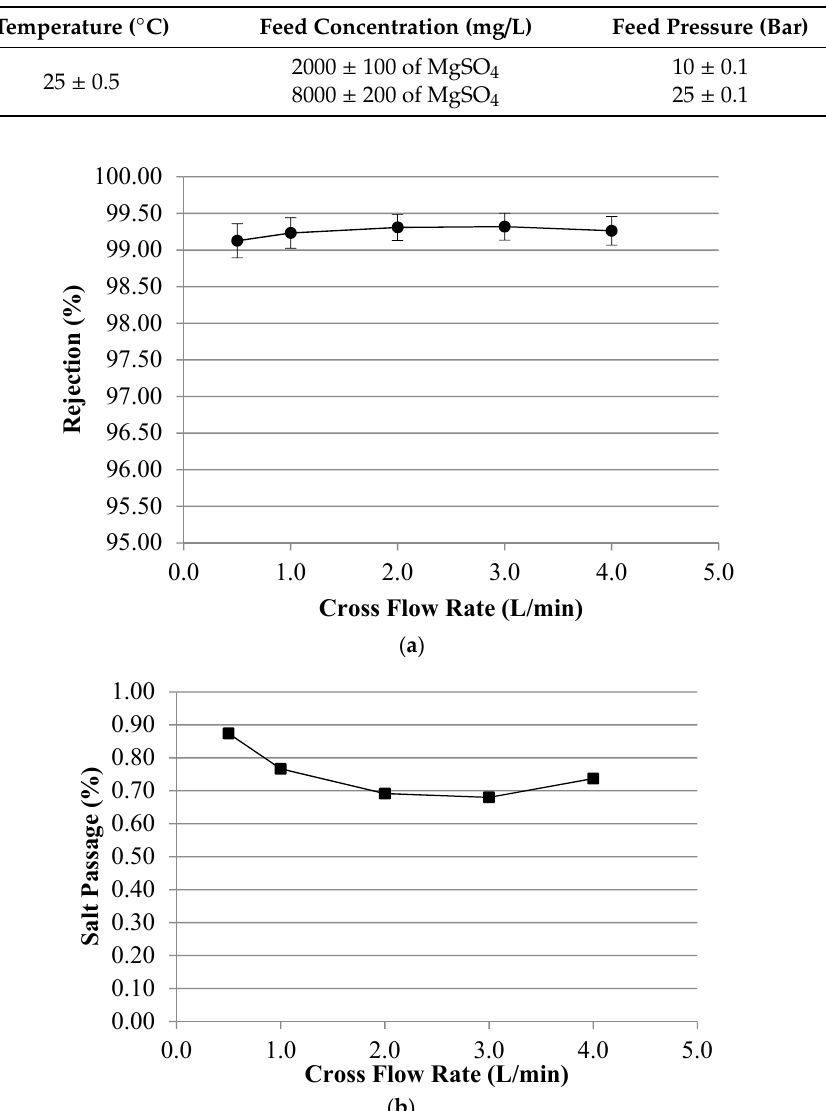
Figure A1. ( a ) Graph of rejection as a function of the cross flow rate (Operating Conditions: 2000 mg / L MgSO 4 , pH 7, 25 ◦ C, and 10 bar). ( b ) Graph of salt passage as a function of the cross flow rate (Operating Conditions: 2000 mg / L MgSO4, pH 7, 25 ◦ C, and 10 bar).